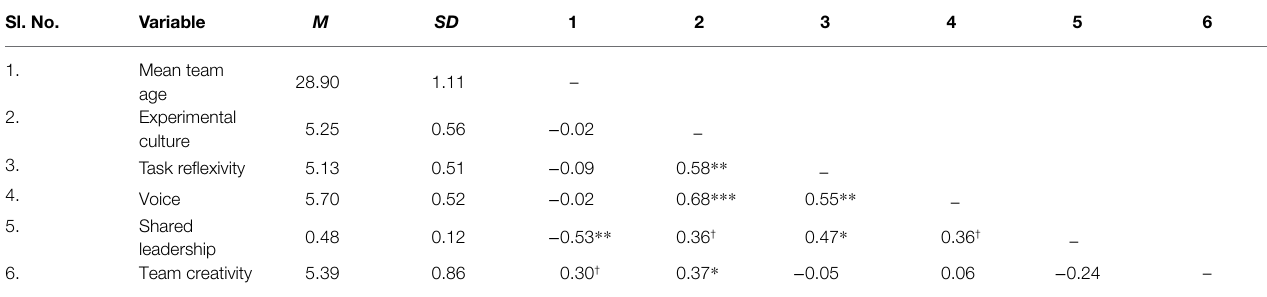
TABLE 4 | Team-level means, standard deviations, and correlations. Sl. No.